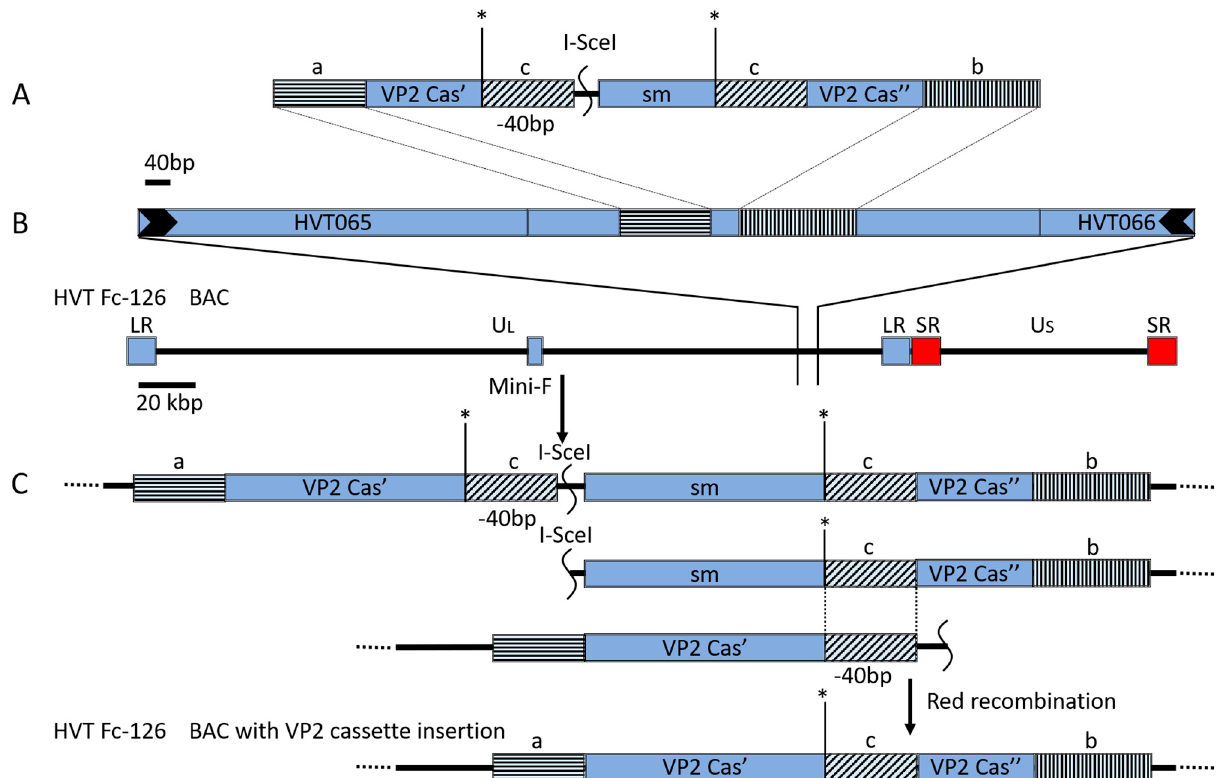
Figure 1. Construction schematic diagram of HVT BAC with insertion of the VP2 expression cassette and RFLP of BACHVT-G, BAC HVT-VP2-09-KAN , and BAC HVT-VP2-09 : ( A ): Kanamycin resistance gene (sm) with a 40 bp homologous sequence (c) was inserted into the Sac I restriction site (*) in the VP2 expression cassette. ( B ): VP2 expression cassette with the selective marker (sm) was inserted into the noncoding area between HVT UL55 and HVT UL56 through the first recombination to generate a recombinant BAC HVT-VP2-09-KAN with both chloramphenicol and kanamycin resistance. ( C ): The second recombination was performed to delete the kanamycin resistance gene to generate the final recombinant VP2 vectored BAC HVT-VP2-09 clone. Rectangles with the same type of shading and the same color indicate identical sequences. Scales in bp or kbp are provided.